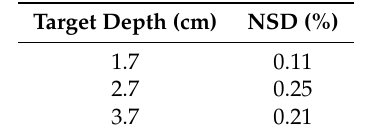
Table 3. Normalized standard deviation (NSD) errors between the k-Wave and the proposed method for the simulation of different target depths with a constant skull thickness, h = 7 mm.